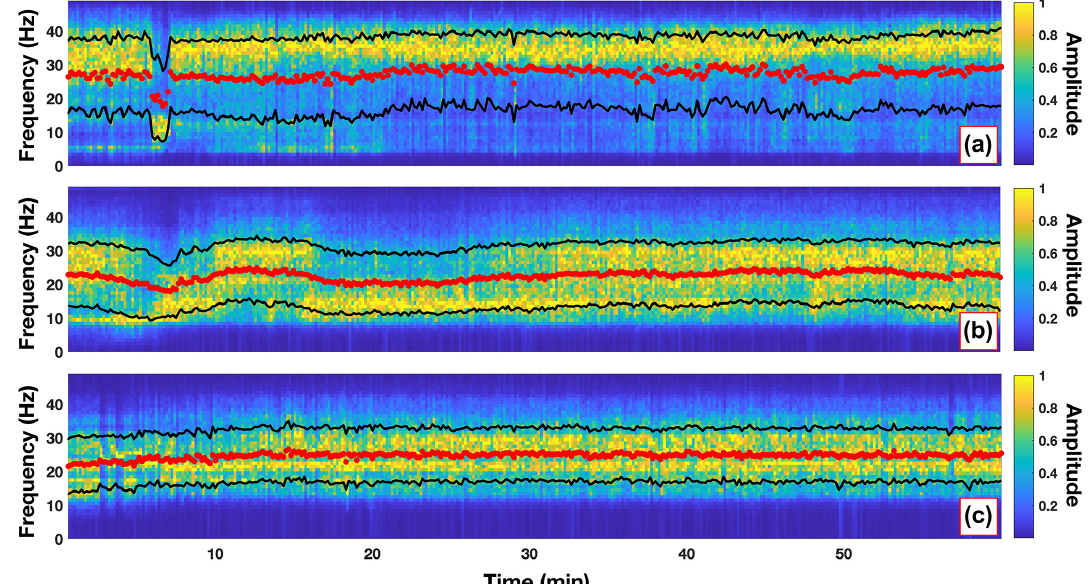
Figure 7. Normalized spectrograms for the flow-parallel direction for each of the three monitoring sites along the Whangaehu channel. Red dots represent the spectral centroidal frequency, and black lines show the range of the spectral spread. Note that normalized spectrograms for the other directions can be seen in Figs.